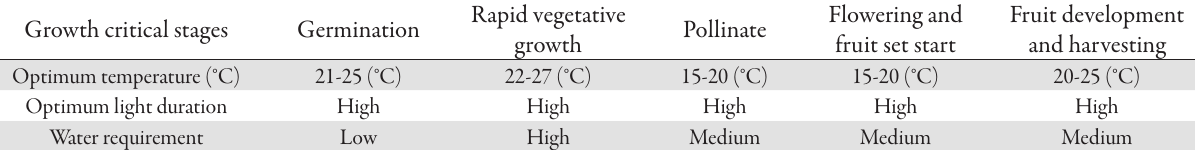
Tab. 2. Environmental factors requirement of summer squash at critical developmental stages